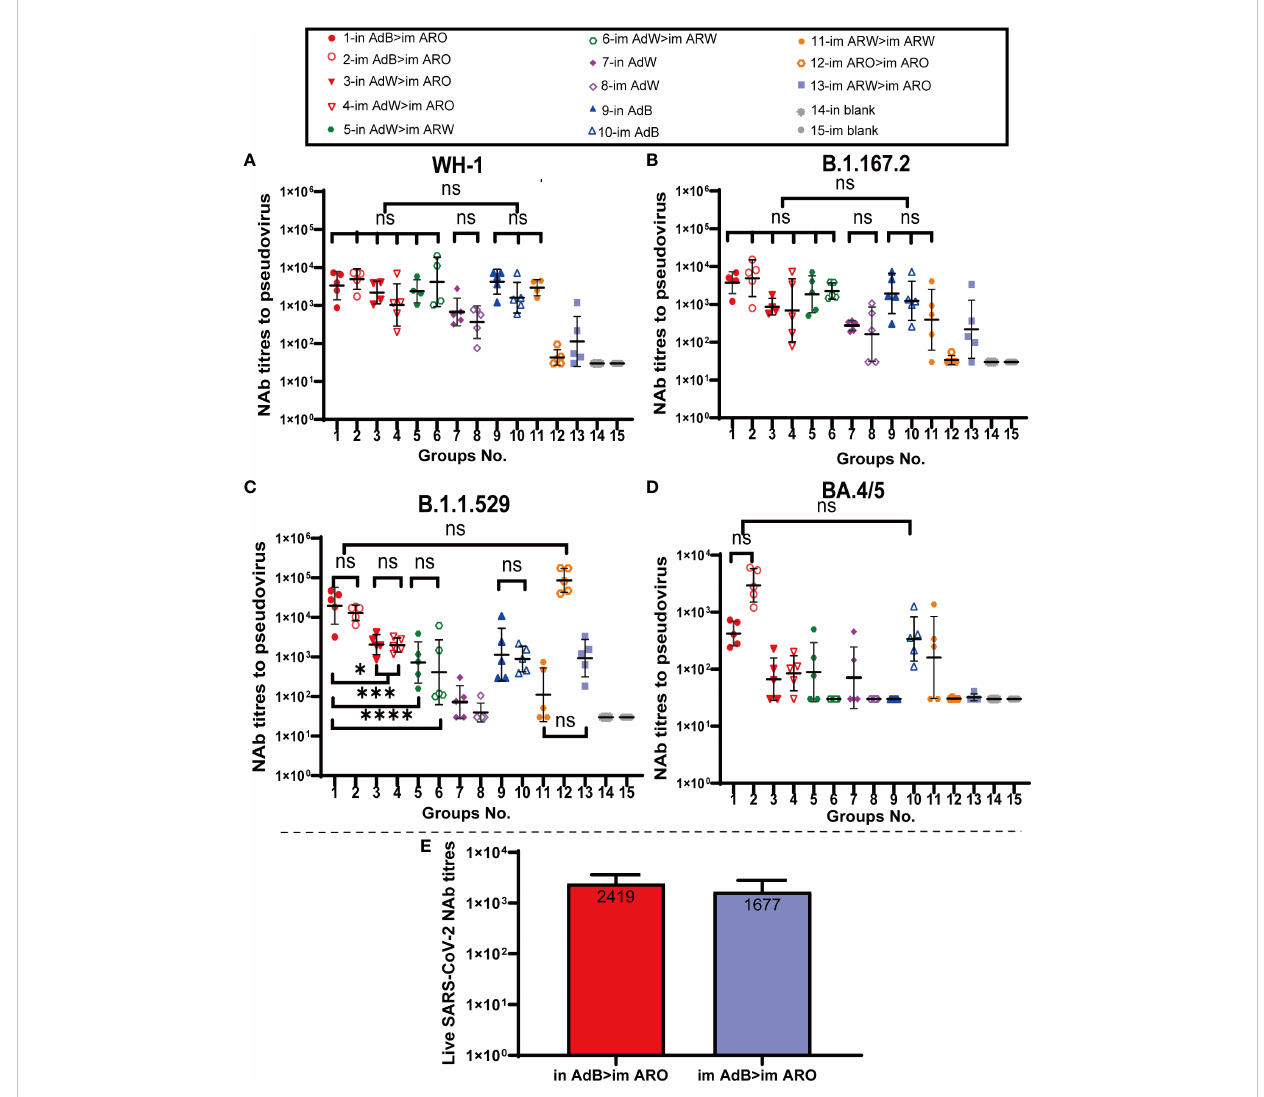
FIGURE 4 NAb titres were measured 49 days after primary immunisation. Serum PNAb titres against (A) WH-1, (B) B.1.617.2, (C) B.1.1.529, and (D) BA.4/5 are expressed as 50% inhibitory dilutions (n = 4 − 5 per group; one spot represents one sample). (E) SARS-CoV-2 NAb titration (n = 3 per group). Bars represent the geometric mean ± geometric SD; *P < 0.05; ***P < 0.001; ****P < 0.0001; ns, P >